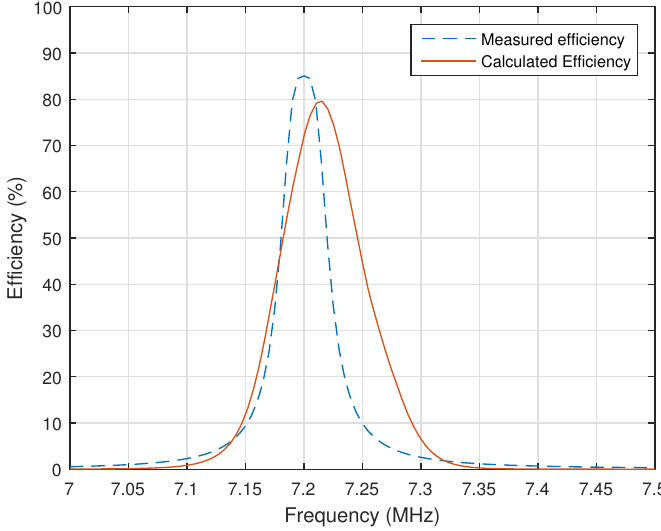
Figure 8. Frequency misalignment between the mathematical model at 7.2 MHz and the experimental setup at 7.22